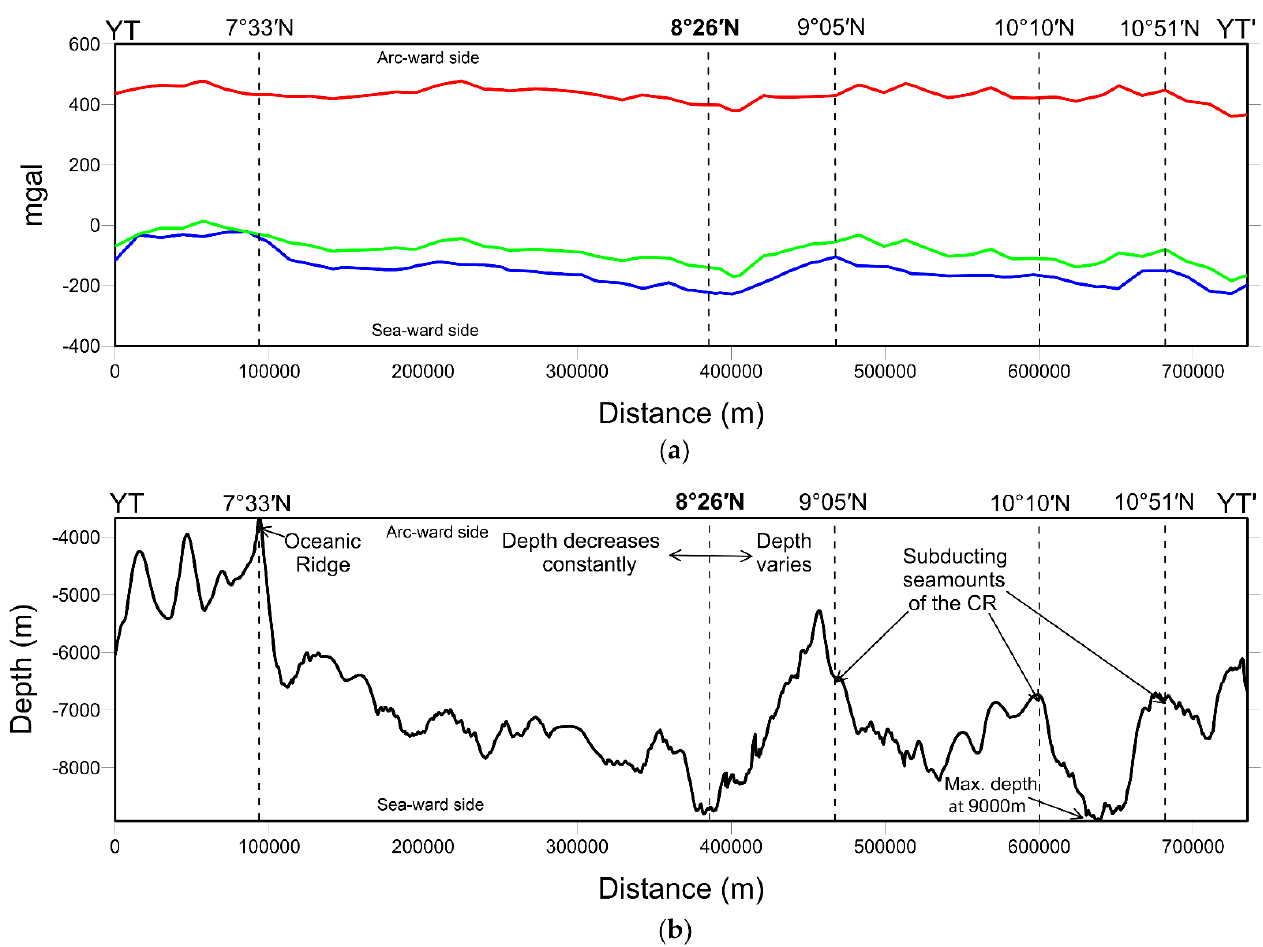
Figure 3. The impact of the CR subduction on the submarine topography of the southernmost Parece Vela Basin, Yap arc, arc-ward trench slope, Yap Trench axis, and sea-ward trench slope in the north and south of 8°26 ′ N. Profiles aa’, bb’, and cc’ are extracted from the line segments aa’, bb’, and cc’ north of 8°26 ′ N, respectively, and profiles dd’ and ee’ are extracted from line segments dd’ and ee’ south of 8°26 ′ N, respectively. See Figure 1 for the location of the line segments, aa’, bb’, cc’, dd’, and ee’, and the abbreviations.